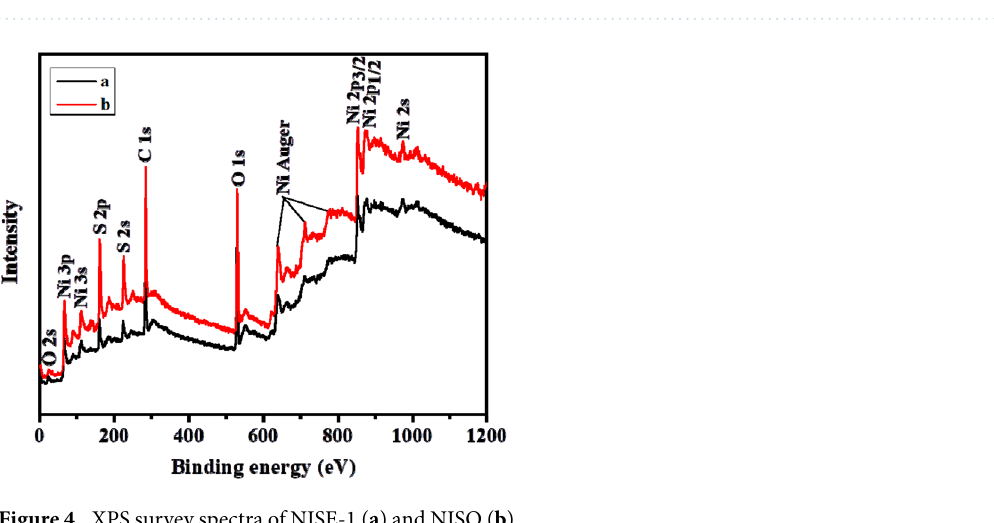
Figure 3. SEM images of NiS nanoparticles synthesized from complex (1) at ( a , b ) 200 °C, and ( c , d ) 400 °C.